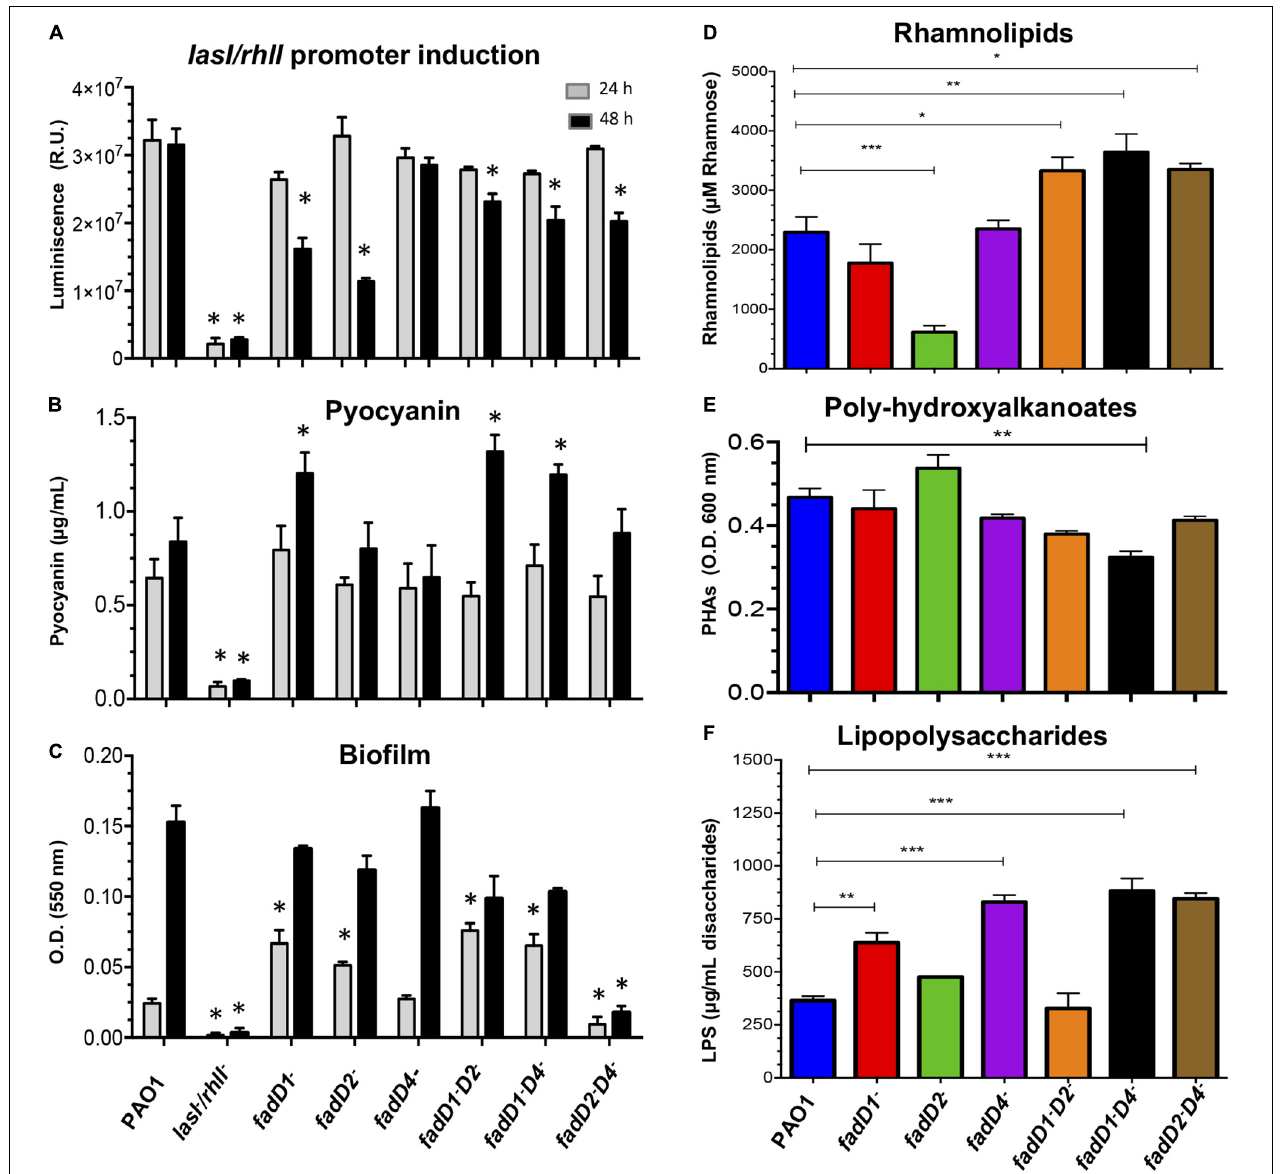
FIGURE 5 | Determination of virulence factors in the cultures of P. aeruginosa PAO1 fadD mutants. (A–C) Determination of virulence factors in the cell-free supernatants of P. aeruginosa PAO1 strains as described in Section “Materials and Methods.” (A) Induction of the las/rhl -dependent biosensor, determined by bioluminescence generation. The assay was performed using the E. coli JM109 reporter strain harboring the pSB1075 plasmid, which produces luminescence in response to 3-oxo-C 12 -HSL. (B) Pyocyanin, (C) biofilm formation, (D) rhamnolipids, (E) polyhydroxyalkanoates, and (F) lipopolysaccharides. (D–F) Cell-free supernatants of 48-h grown cultures. Bars represent the mean ± SE of three independent experiments. One-way ANOVA was performed, with Bonferroni post